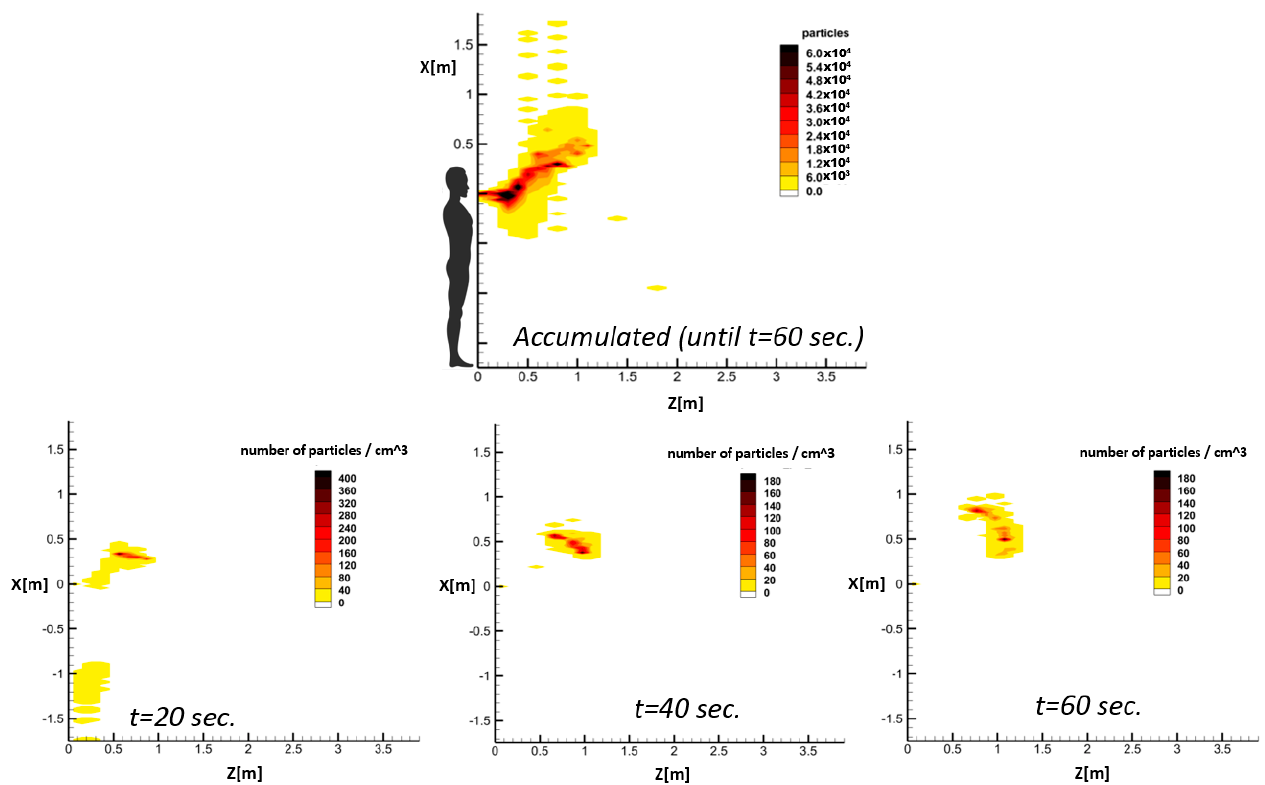
Figure 9. ( top ) The accumulated spread pattern until t = 60 s against ( bottom ) the time-resolved droplet concentration for a cough case at t = 20, 40, and 60 s (velocity = 8 m.s − 1 , temperature = 29 °C, RH = 80%).